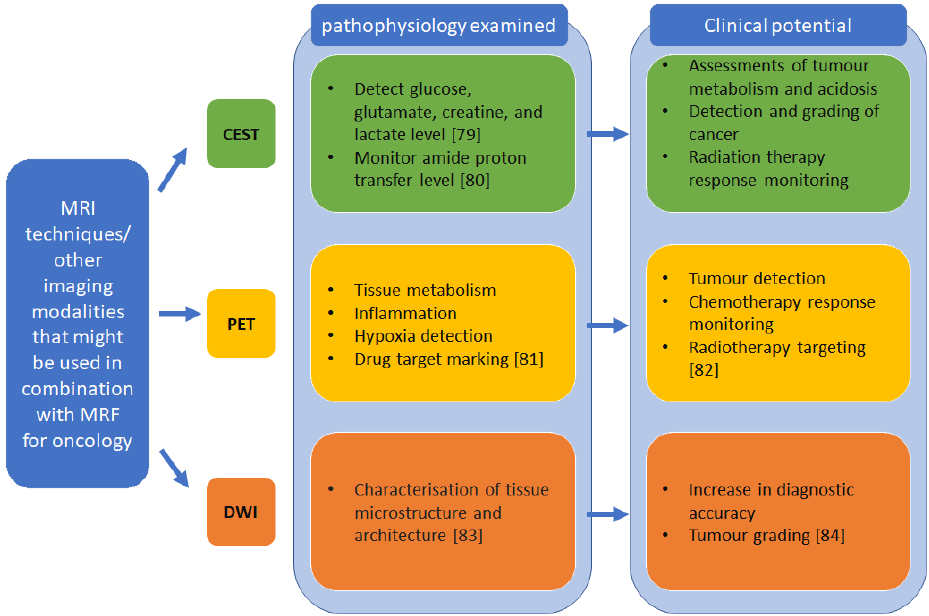
Figure 6. MRI techniques and other imaging modalities that could be explored in combination with MRF in oncology [79 – 84]